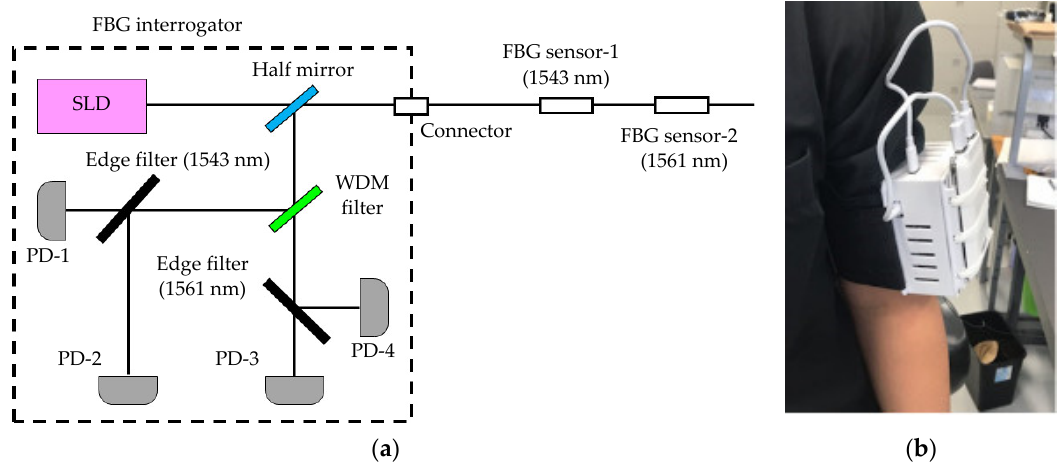
Figure 2. Diagram and photo of FBG sensor system. ( a ) FBG interrogator and FBG sensor; ( b ) developed edge-filter module-type FBG interrogator.